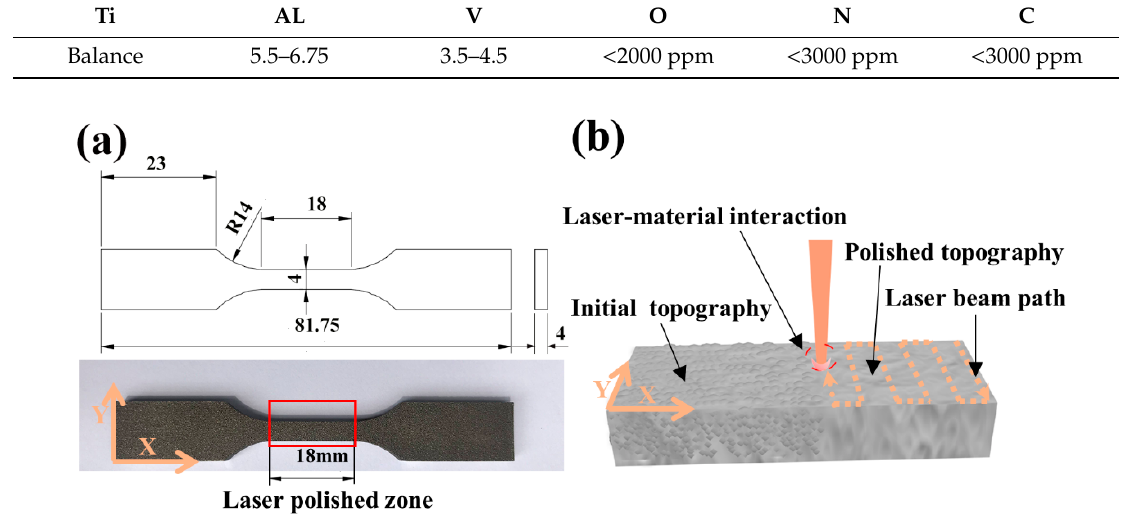
Figure 1. ( a ) Test specimens; ( b ) a schematic view of the laser polishing (LP). Table 2. LP parameters of di ff erent